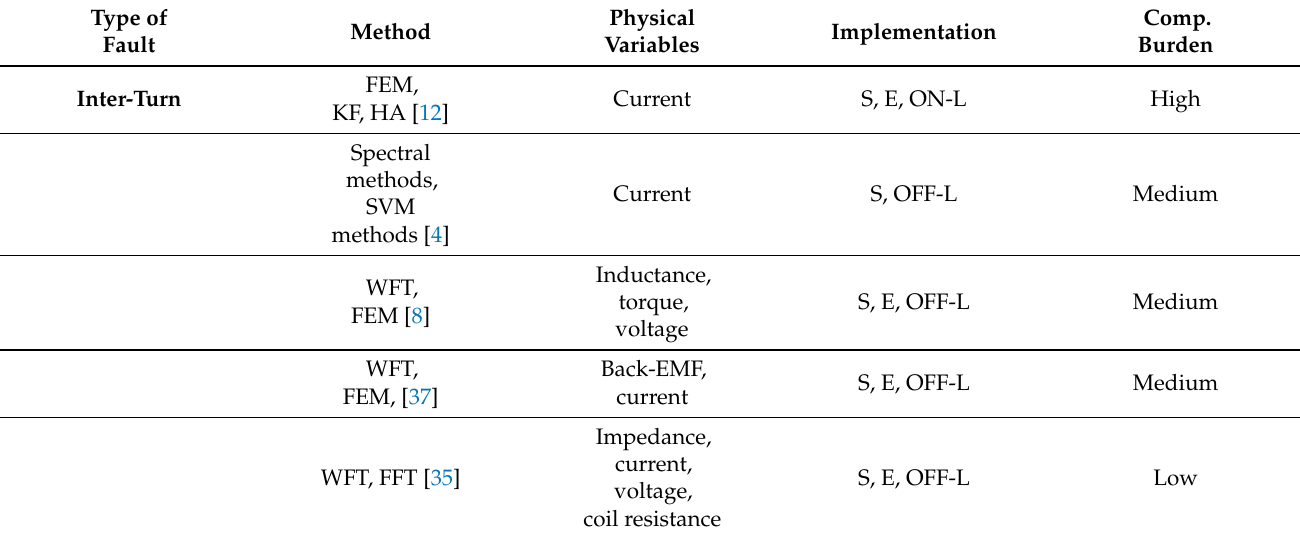
Table 6. Description of diagnostic methods for stator faults in BLDC motors. For the